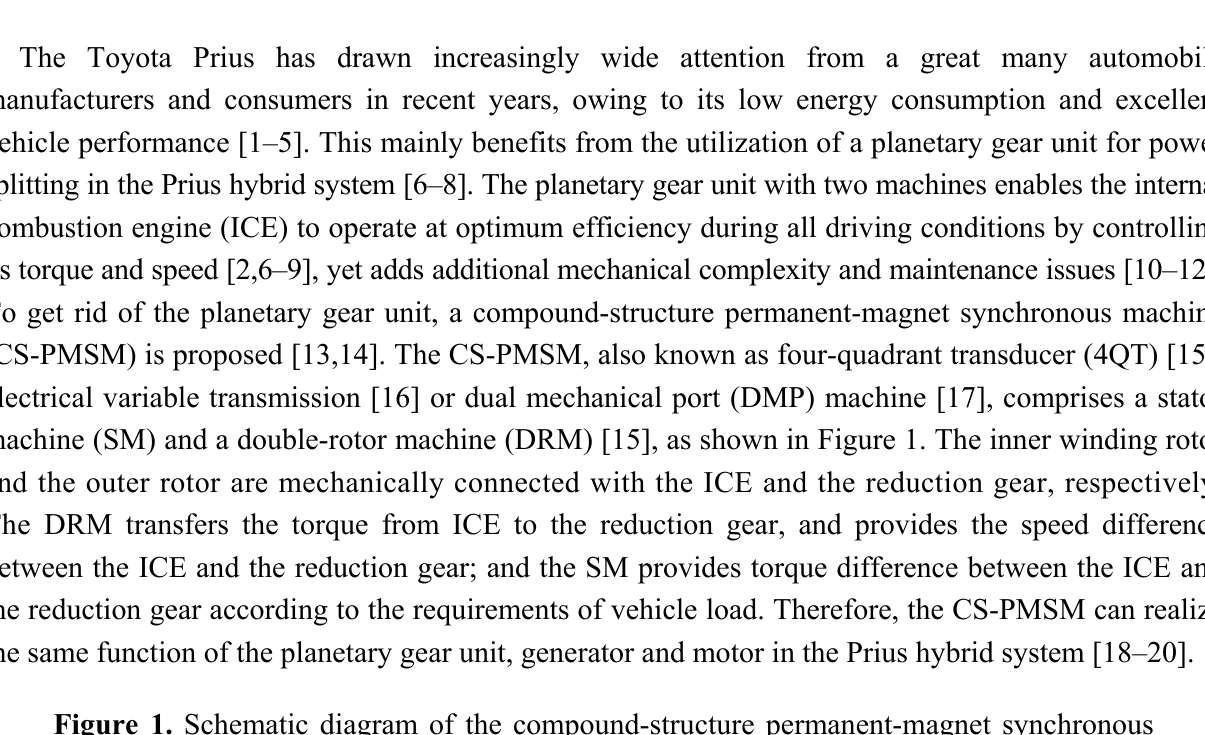
Figure 1. Schematic diagram of the compound-structure permanent-magnet synchronous machine (CS-PMSM) hybrid system. ICE: internal combustion